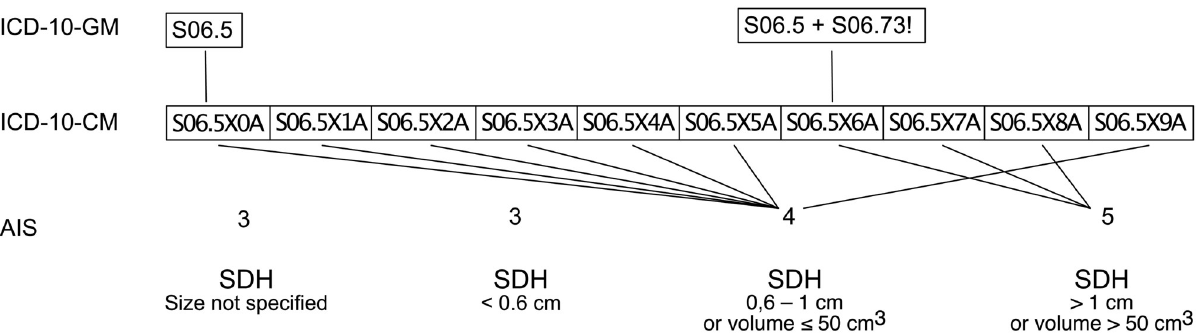
Fig 4. Exemplary visualisation of the mapping process from ICD-10-GM into AIS codes. The necessary information to sufficiently encode AIS scores is not displayed in the ICD system in general. ICD-10-GM = German modification of the International Statistical Classification of Diseases and Related Health Problems 10th revision. ICD-10-CM = Clinical modification of the International Statistical Classification of Diseases and Related Health Problems 10th revision. SDH = Subdural haematoma. AIS = Abbreviated injury scale.